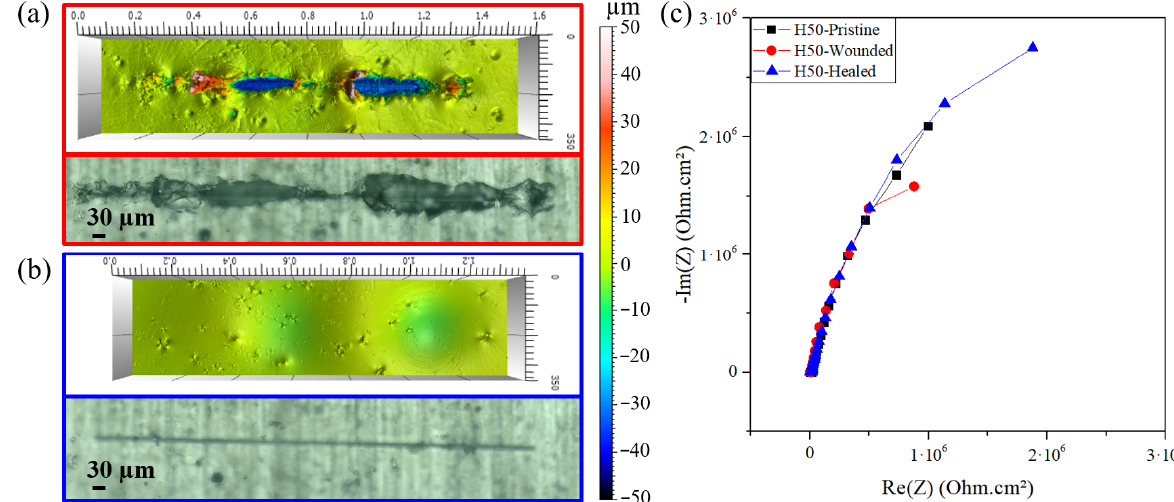
Figure 14. Optical and interferometric analysis of ( a ) scratched and (b ) healed H50 coating after 18 h at 75 °C, ( c ) Nyquist plots of pristine, scratched and healed H50 coating.